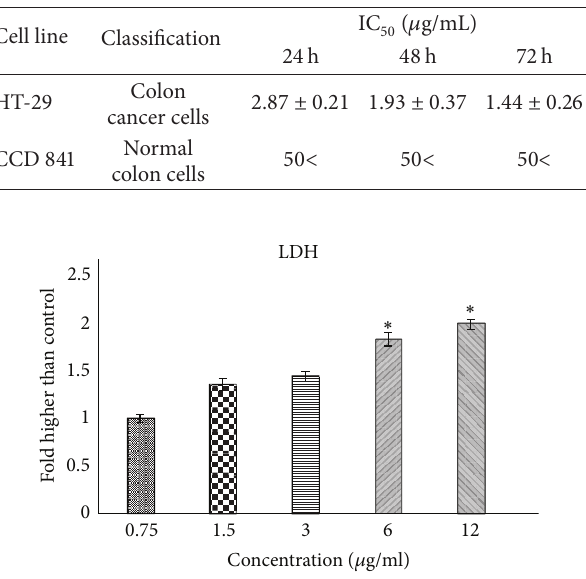
Figure2:TheLDHreleaseassayrevealedthesignificantcytotoxicity of the Cu(BrHAP) 2 compound on HT-29 cells at the 6.25 and 12.5 𝜇 g/mL concentrations.